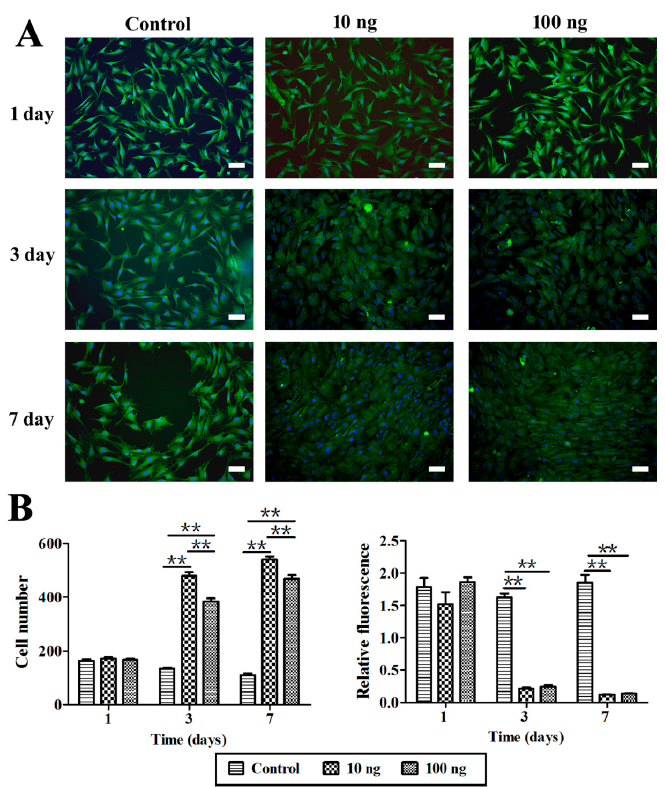
Figure 3. Observation and analysis of chondrocytes in vitro by high content screening. ( A ) The immunofluorescence image of chondrocytes, scale bar is 100 µ m; ( B ) The cell number of chondrocytes content by nucleus and the calculated mean intensity of collagen type II according to the number of DAPI stained cells. 10 ng means 10 ng/mL, 100 ng means 100 ng/mL BMP3 in the culture media; control, without BMP3. Mean ± SD, n = 3; ** p < 0.01.